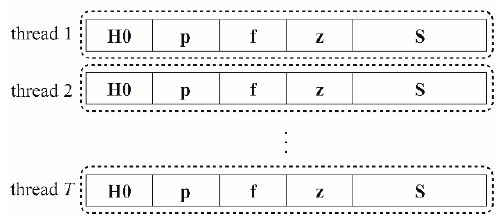
Figure 4. Memory management where each thread has its own memory pool with private variables.